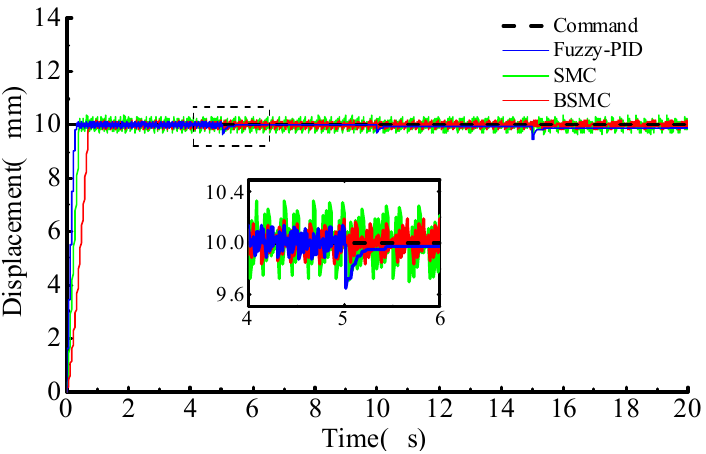
Figure 6. Step response of the cylinder under random load. Given sinusoidal instruction displacement, the displacement response of the hydraulic cylinder by applying the random load force is shown in Figures 7–9. In the random load range of 0–500 N, the output displacement of the hydraulic cylinder with backstepping sliding-mode control has the best anti-interference ability, the displacement tracking effect is very ideal, and the fuzzy PID has the worst robustness.